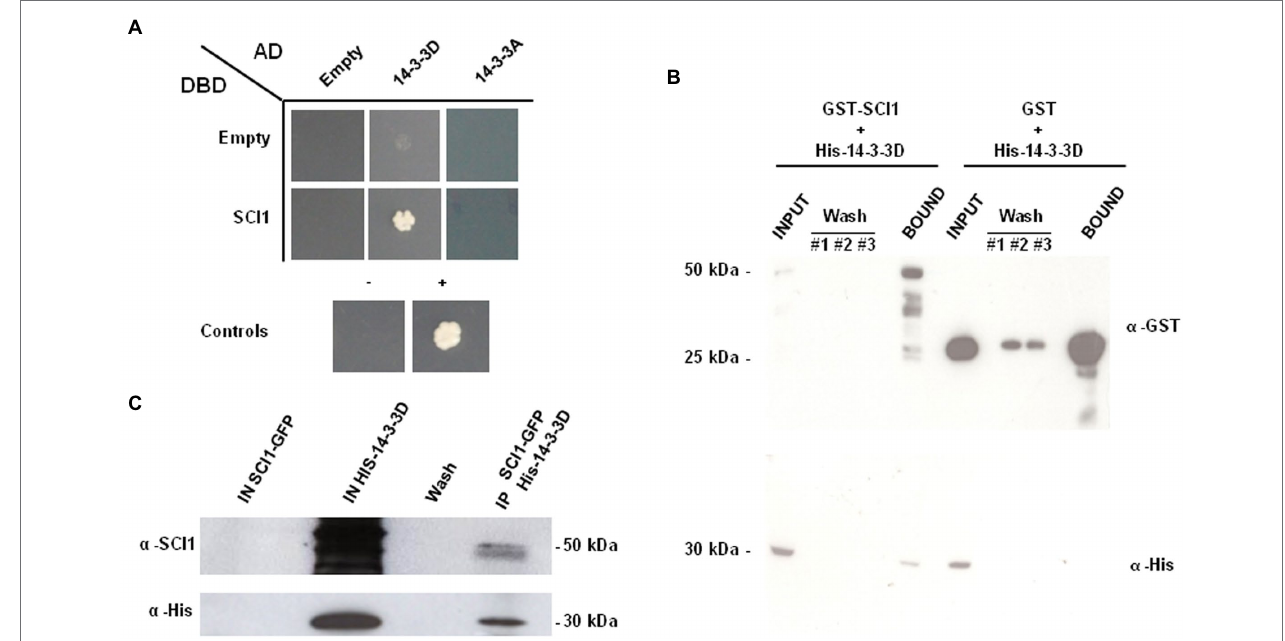
FIGURE 1 | (A) Yeast two-hybrid (Y2H) binary assays of the interaction of BD-SCI1 with AD-14-3-3D and AD-14-3-3A proteins. Yeast PJ69-4a cells with empty vectors are unable to grow on a selective medium without histidine. The self-activation of BD-SCI1, AD-14-3-3D, and AD-14-3-3A were negative. Cells could only grow when BD-SCI1 and AD-14-3-3D proteins were present, showing HIS3 reporter gene expression and confirming the interaction between these proteins. (B) In vitro pulldown with recombinant GST-SCI1, GST, and HIS-14-3-3D produced in Escherichia coli . (C) Co-immunoprecipitation of HIS-14-3-3D protein using an extract of stigmas/styles from Nicotiana tabacum 35S prom ::SCI1-GFP plants. The smear observed at the input HIS-14-3-3D lane is due to background recognition of E. coli proteins by the anti-HIS-SCI1 polyclonal